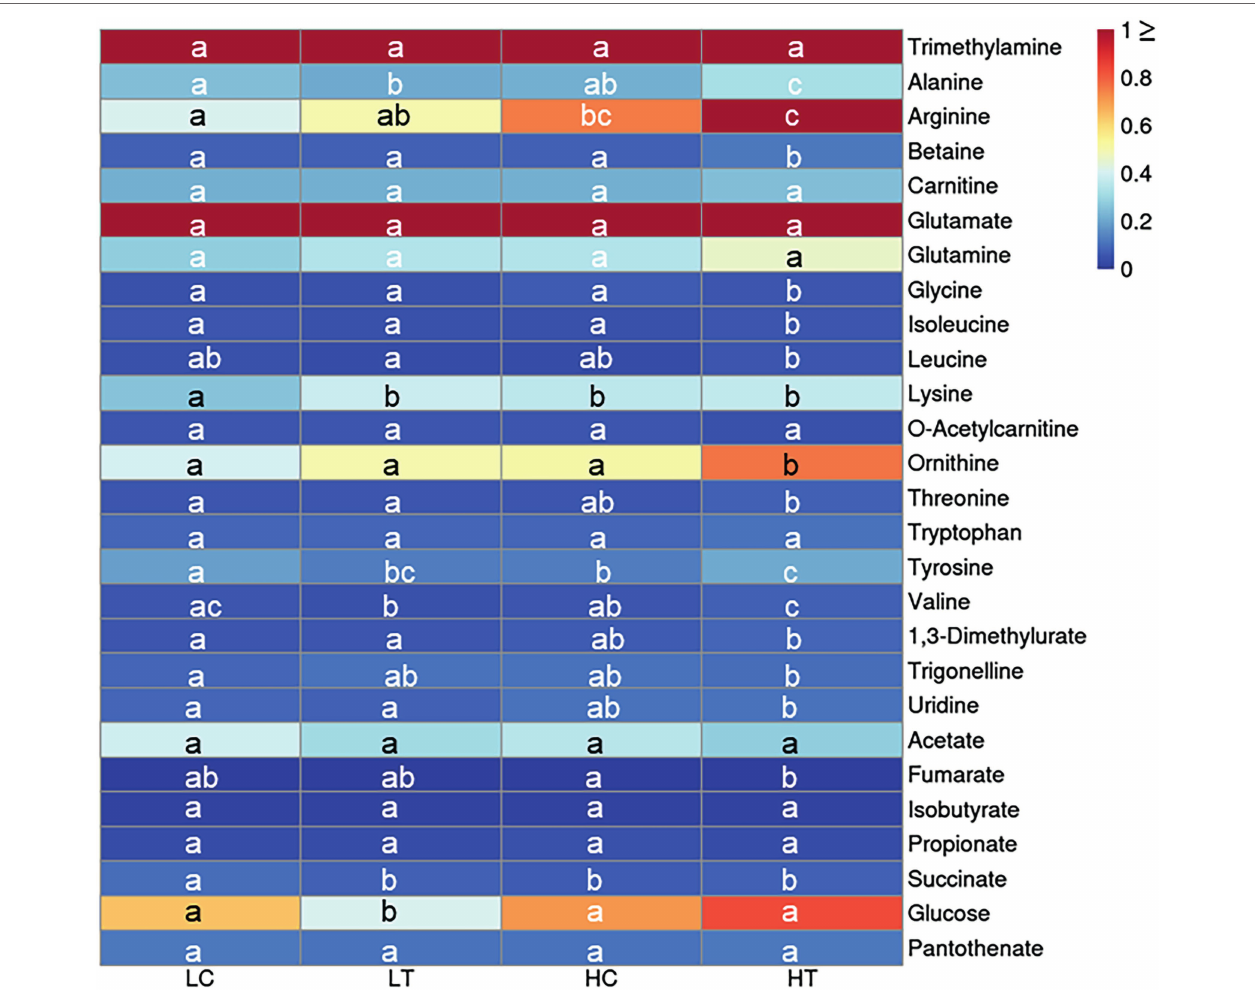
FIGURE 3 | Heatmap for key cellular metabolites detected by NMR in Symbiodinium sp. under LC, LT, HC, and HT and NN conditions. Letters a–c represent significant differences (value of p < 0.05) between